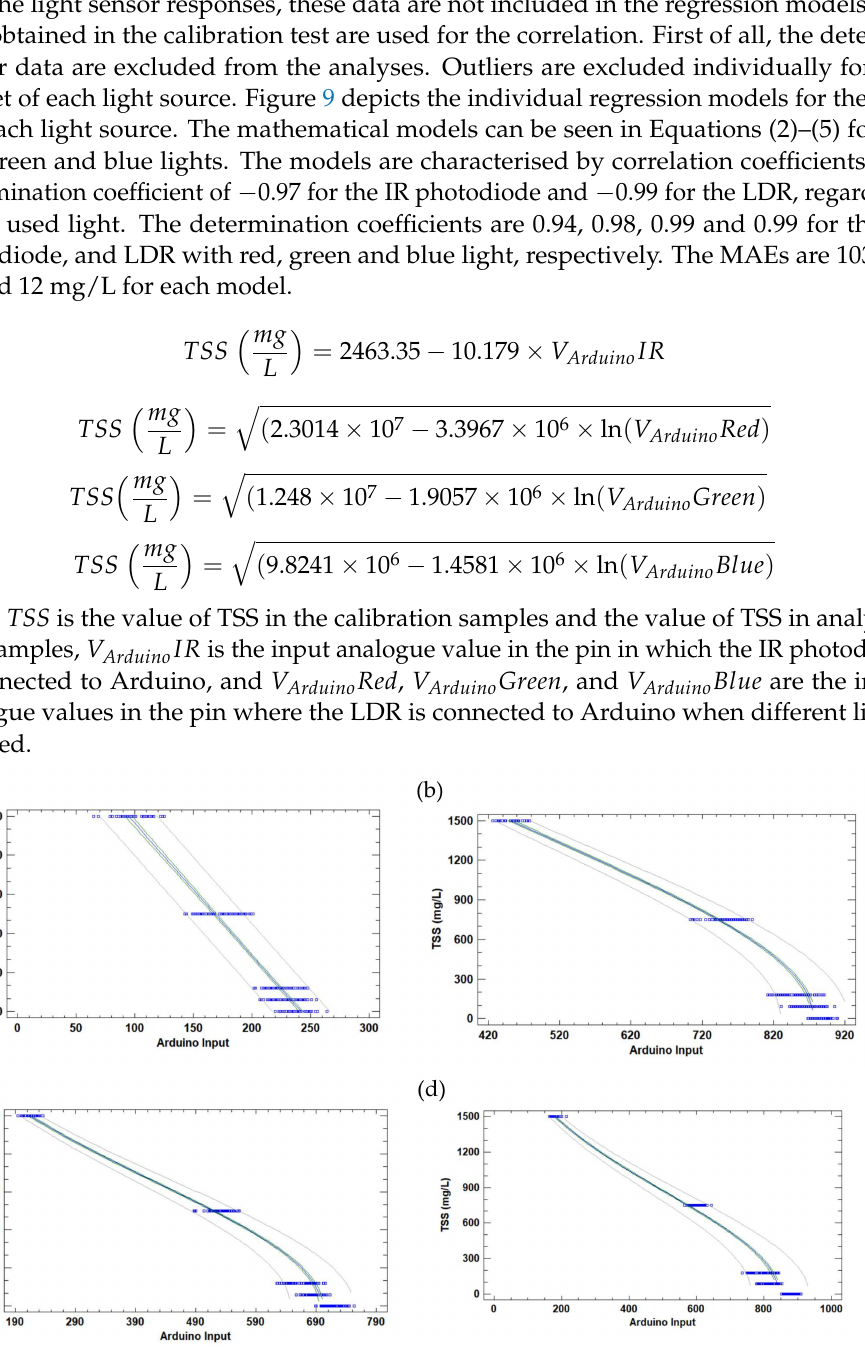
Figure 9. The calibration of the TSS sensor for different light sources: ( a ) IR light, ( b ) red light, ( c ) green light, and ( d ) blue light. Blue squares represent the calibration data. The blue line is the mathematical model, the green lines are the confidence interval, and the grey lines are the prediction